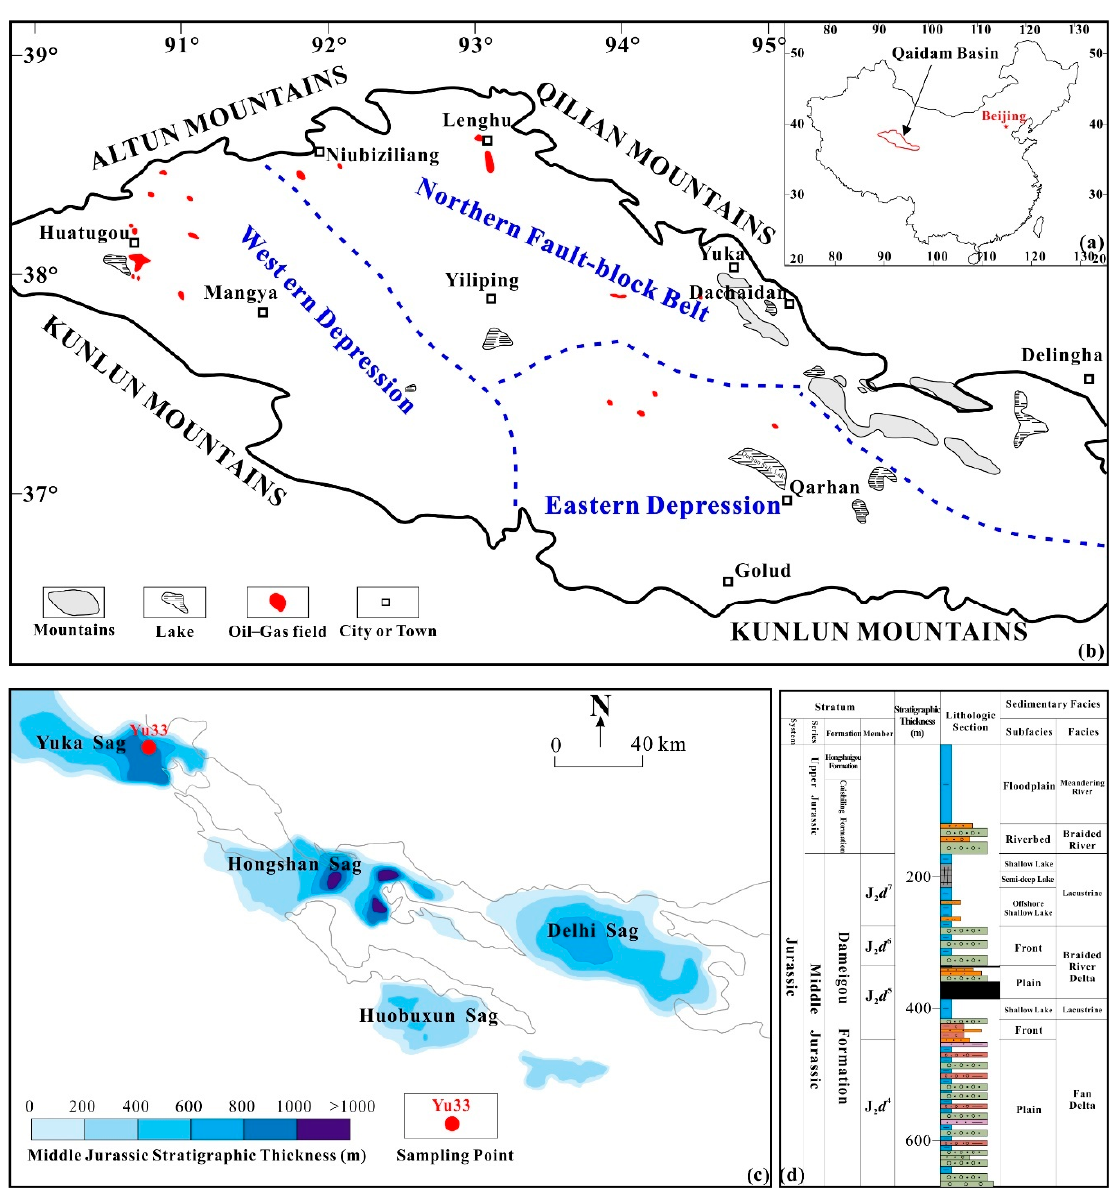
Figure 1. Location and geological features of the Yuka Sag, Qaidam Basin. ( a , b ) Location of the Qaidam Basin and distribution of the Qaidam Basin’s northern margin; ( c ) strata thickness of the Middle Jurassic in northern margin of the Qaidam Basin; ( d ) Jurassic lithostratigraphic section of the Qaidam Basin.